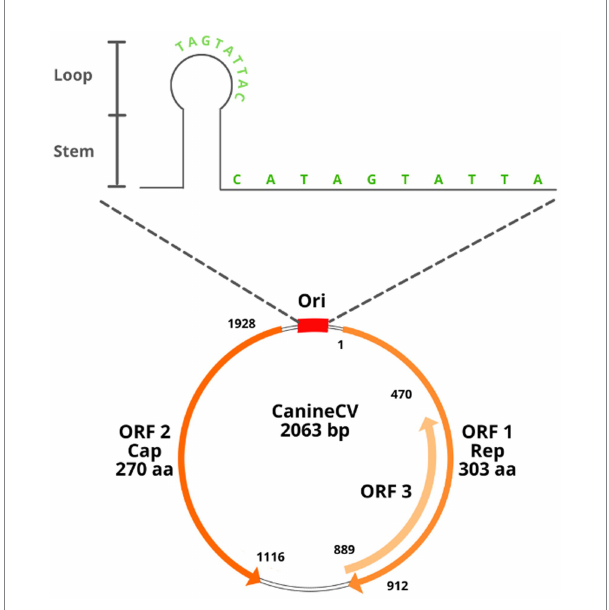
FIGURE 1 Structural diagram of the CanineCV genome. See text for